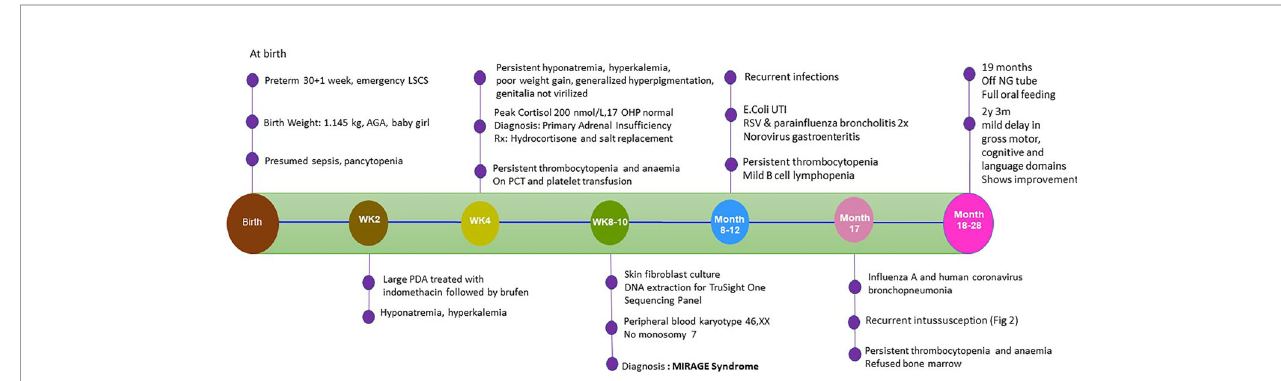
FIGURE 3 | Timeline of events from birth until 28